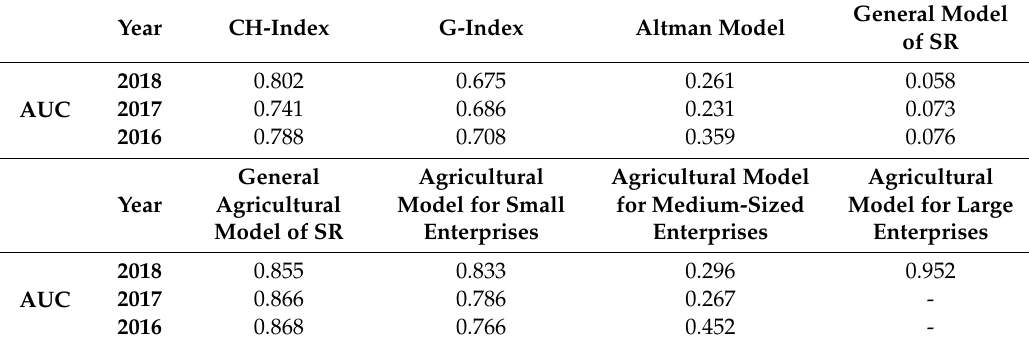
Table 6. Prediction accuracy of models measured by